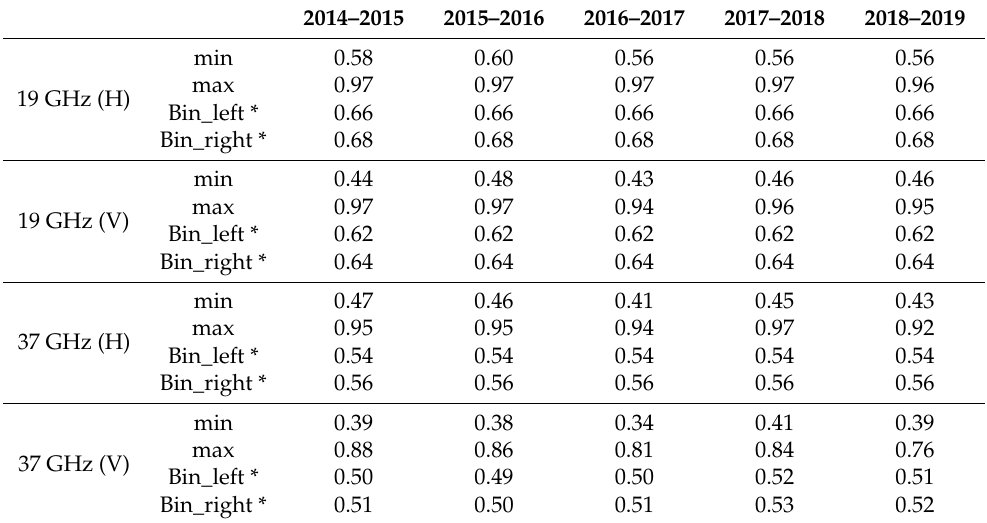
Figure 5. Frequency distribution histogram of transmissivity estimation results. Table 3. Summary of extreme value and mode interval distribution of transmissivity estimation